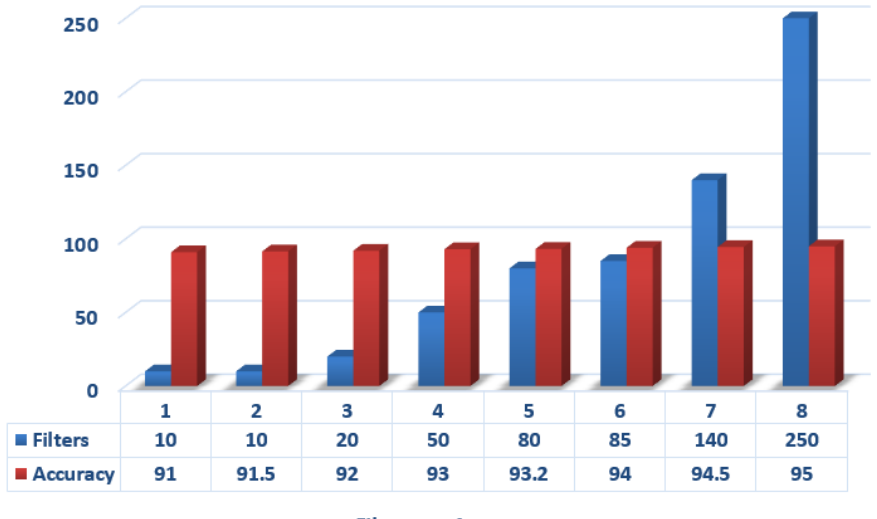
Figure 8. Comparison of deep learning classifiers in different size of filters.